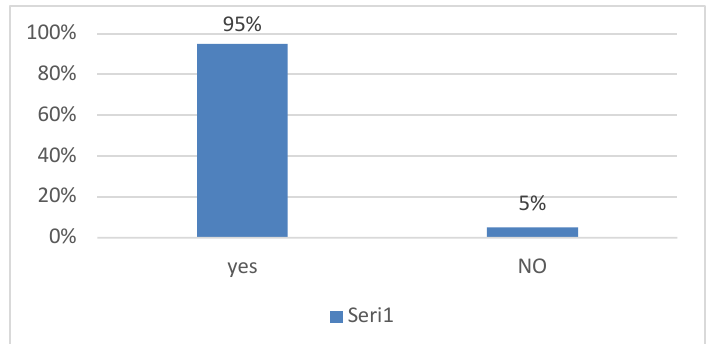
Figure 4: Answers onDo you drink coca cola?